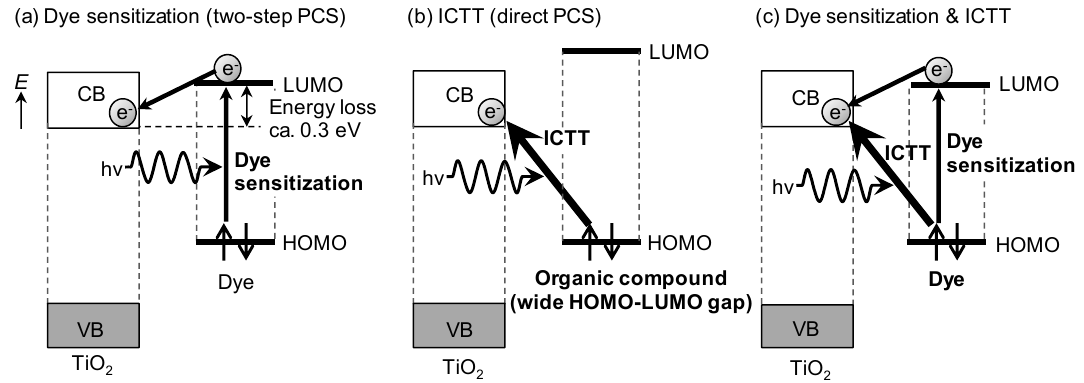
Figure 2. Schematic energy level diagrams of ( a ) dye sensitization of TiO 2 (two-step PCS), ( b ) ICTT between an organic compound with a wide HOMO–LUMO gap and TiO 2 (direct PCS), and ( c ) dye sensitization and ICTT between a dye and TiO 2 . CB and VB denote the conduction band and valence band, respectively. HOMO and LUMO stand for the highest occupied molecular orbital and the lowest unoccupied molecular orbital, respectively.